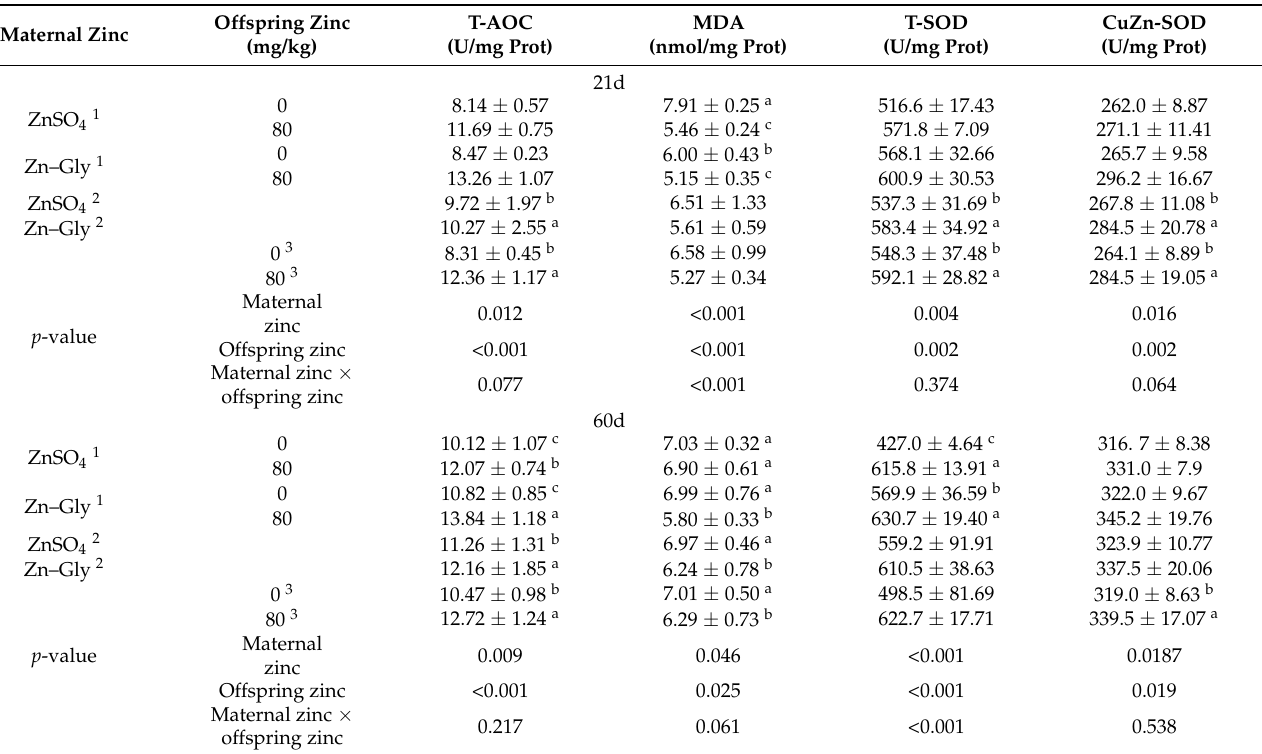
Table 5. Effects of maternal Zn in conjunction with their offspring dietary Zn supplementation on serum antioxidant indexes in offspring broilers (mean ±